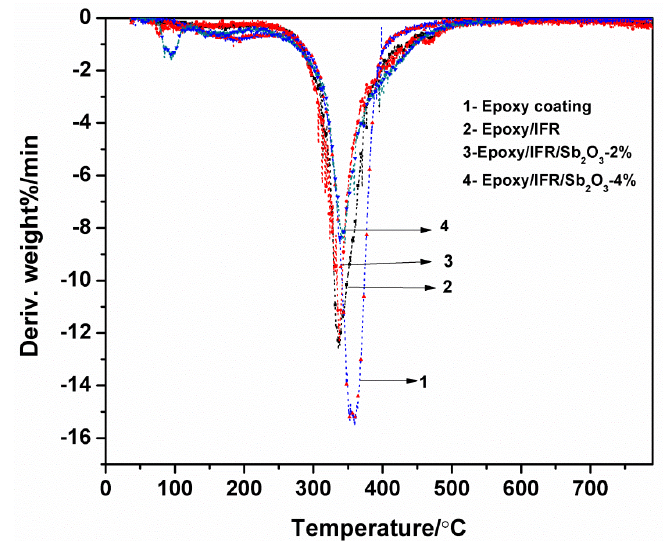
Figure 7. TGA curves of coatings.